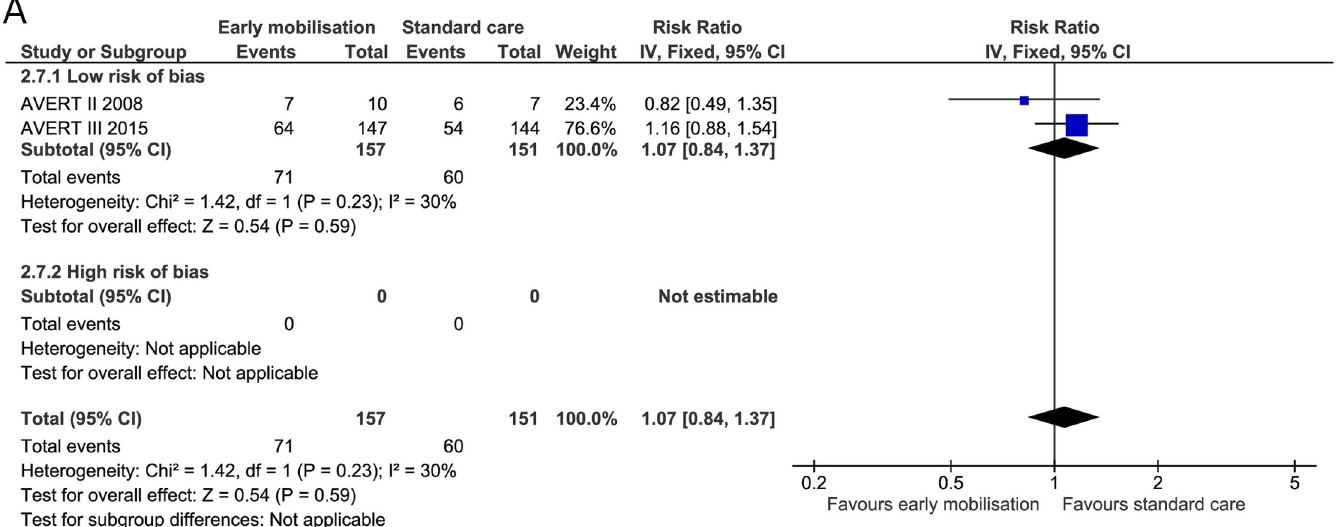
Fig 14. Comparison of early mobilisation versus standard care–Coma Recovery Scale-Revised at maximal follow-up. Fig 14A and 14B. Forest-plot showing the results from the random-effects meta-analysis of the outcome Coma Recovery Scale-Revised at the longest follow-up with subgroup divided according to risk of bias (A) or diagnosis (B).